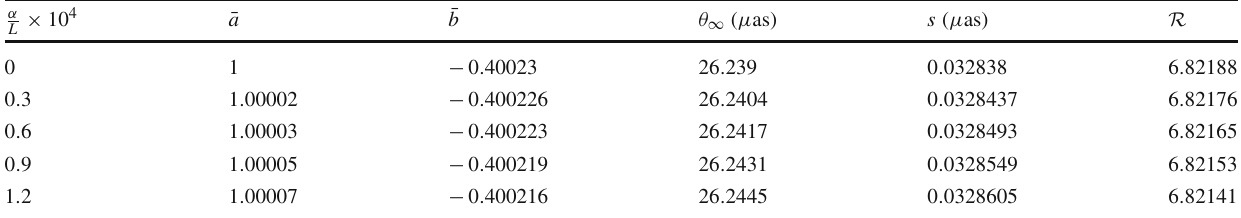
Table 3 The numerical estimation of the observables of the strong gravitational lensing for the case of Sagittarius A ∗ SMBH